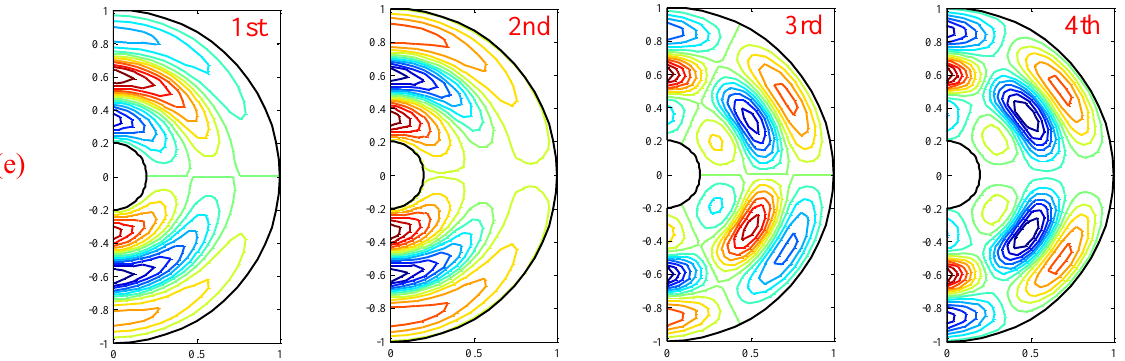
Figure 14: The lowest four mode shapes for a CFCF laminate annular sector plate with various line supports:(a) None; (b) r 1 = R /2; (c) r 1 = R /3, r 2 =2 R /3; (d) r 1 = R /2, θ 1 = ϕ /2;(e) r 1 = R /3, θ 1 = ϕ /2, r 2 =2 R /3.